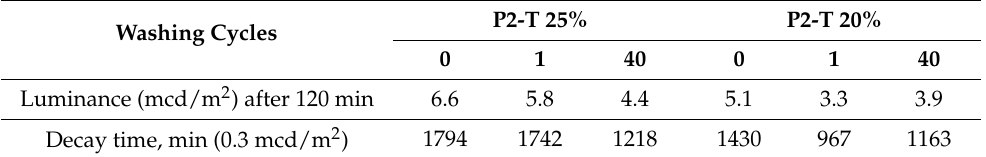
Table 7. Luminance decay obtained by samples coated with 20% and 25% of P2 pigment treated to improve fastness to washing after 0, 1 and 40 washing cycles (40 ◦ C, 40 min).